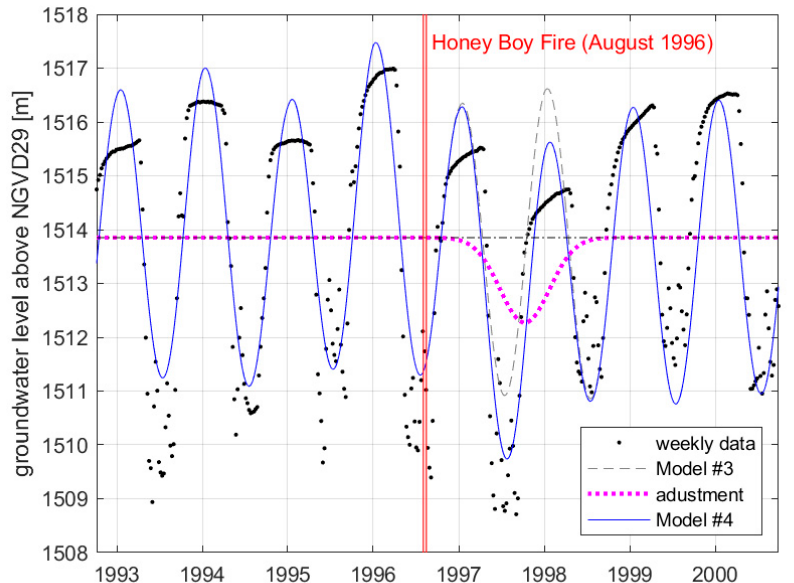
Figure 11. Fire-adjusted model #4 does not change the RMSE for the pre-fire period but provides a 6.3% improvement for the post-fire period (Table 4). The impact of the Honey Boy Fire is modeled as a Gaussian deviation from the precipitation-adjusted model #3, where the Gaussian deviation is centered 434 days after the beginning of the fire, with a standard deviation of 106 days, and a maximum groundwater level depression of 1.58 m.